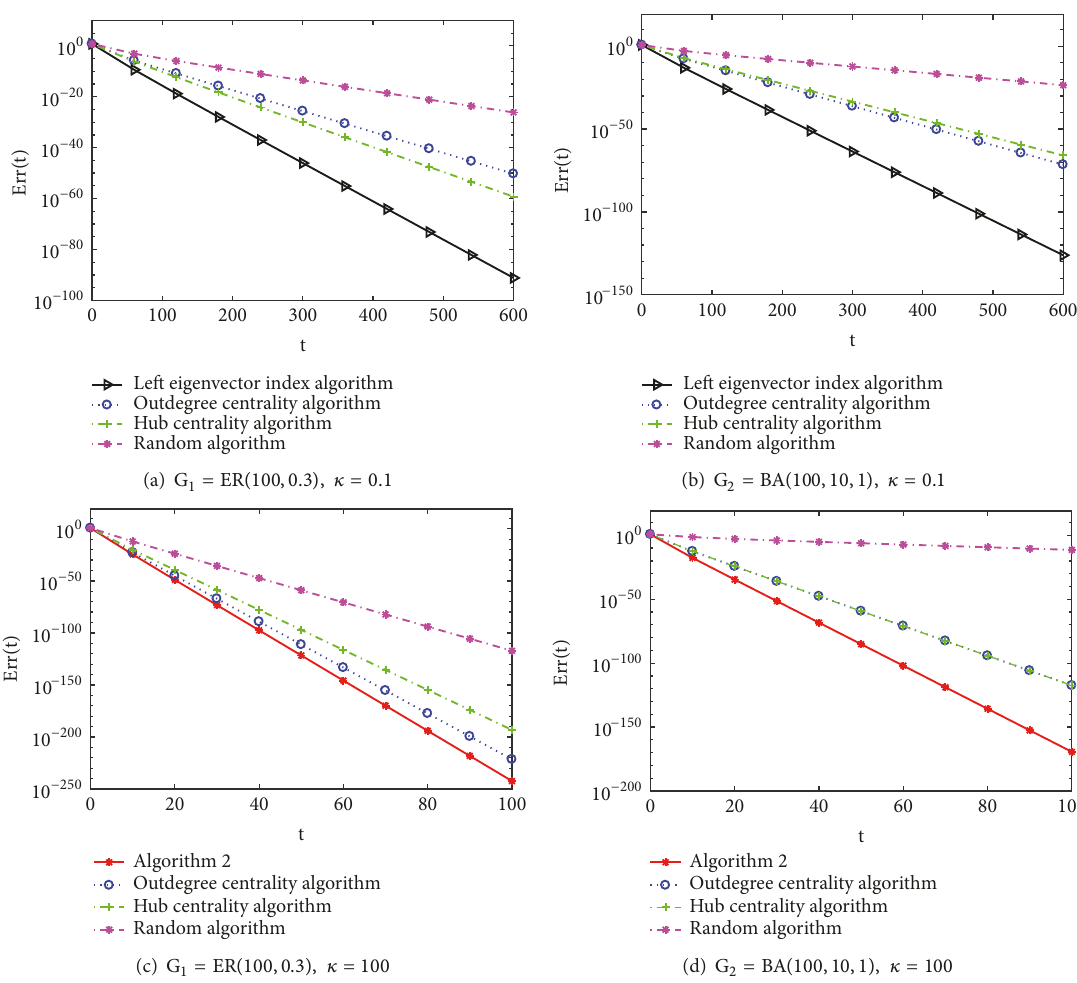
Algorithm 2 Outdegree centrality algorithm